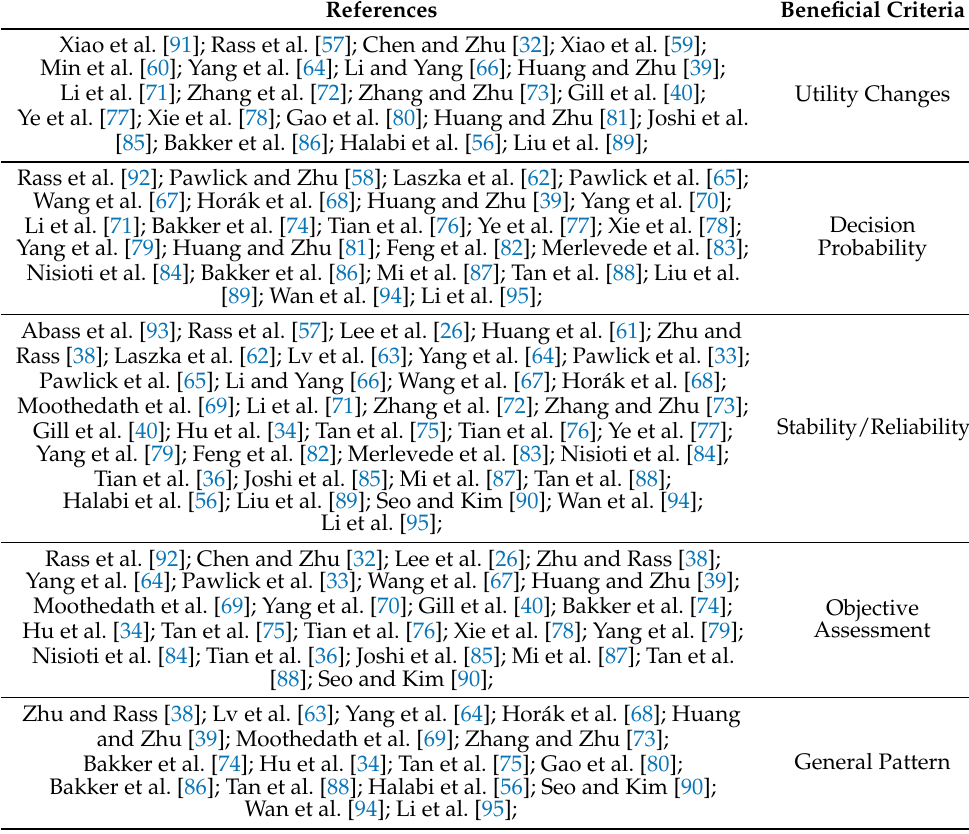
Table 8. Summary of the benefits of game-theory approaches against APTs based on the research